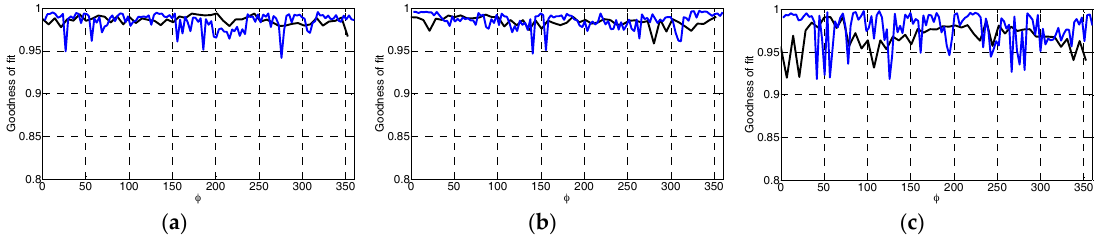
Table 5. Mean and standard deviation of profile GOF over 120 profiles.